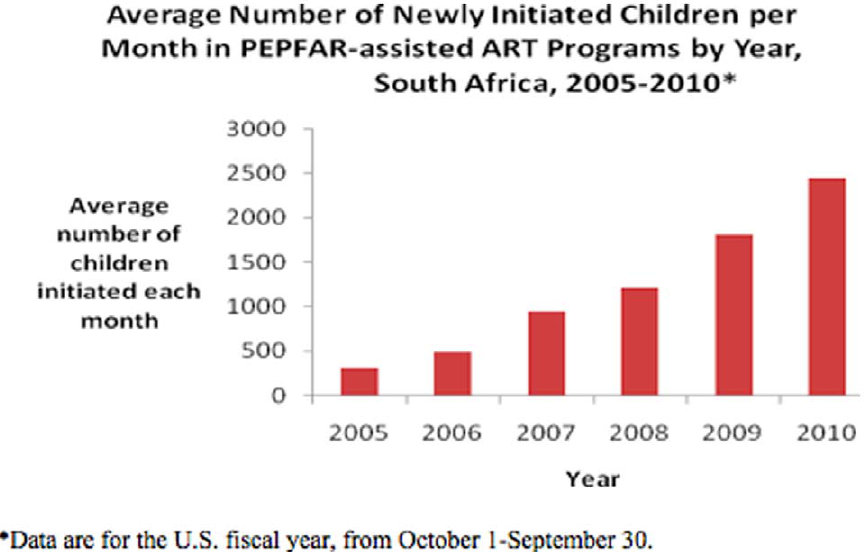
Figure 3. Average Number of Newly Initiated Children per Month in PEPFAR-assisted Antiretroviral Therapy (ART) Programs by year, South Africa, 2005–2010.